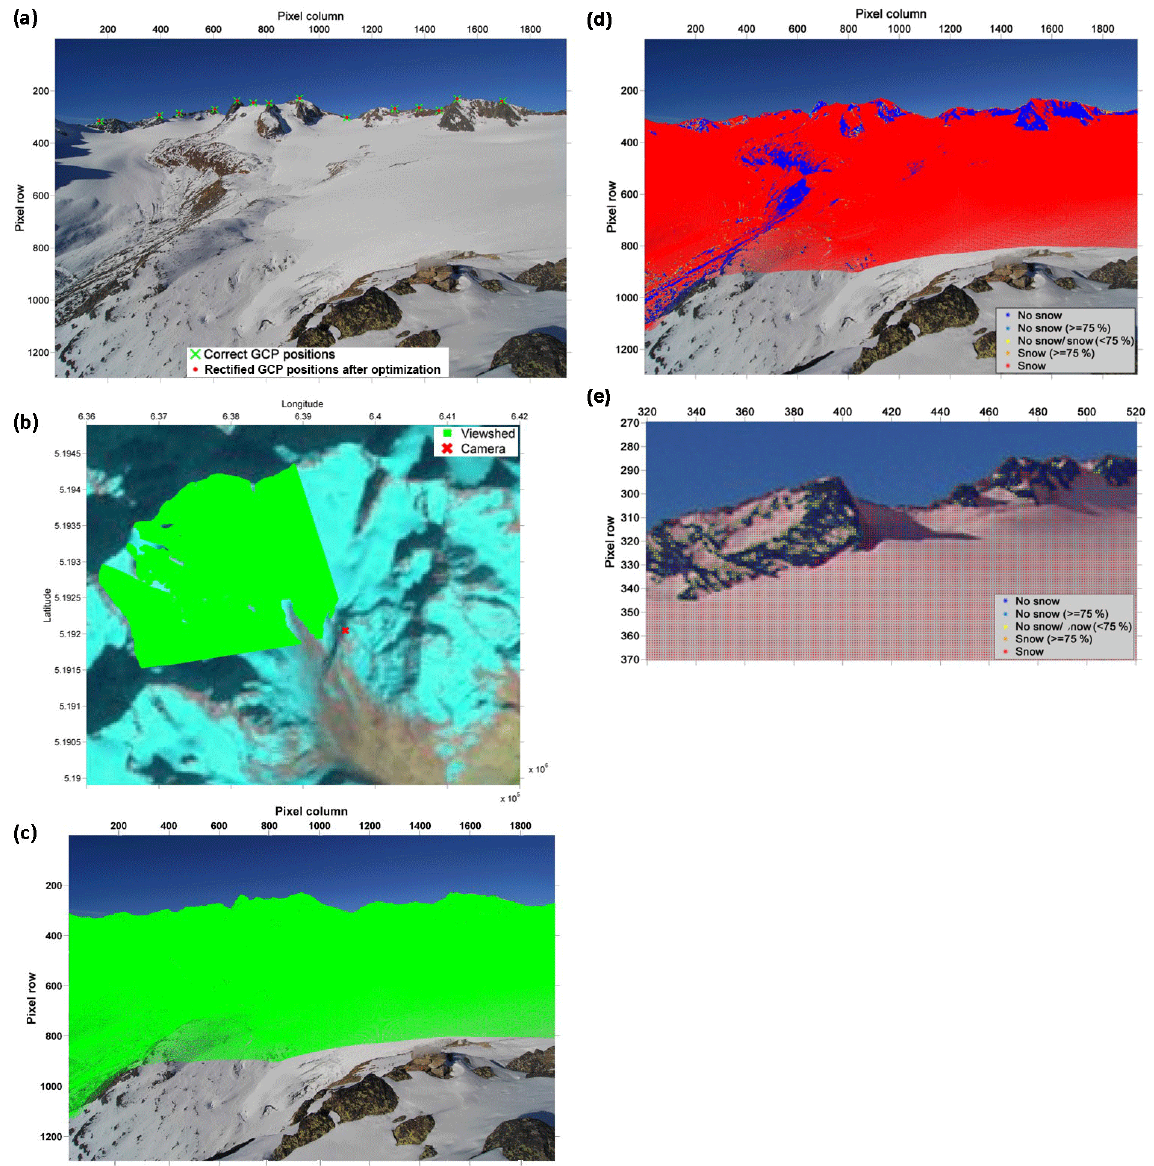
Figure 4. Internal processing steps within a single PRACTISE evaluation are shown for a photograph of VF on 17 November 2011. The figures chronologically show the routines for the photograph processing in PRACTISE which are (a) the optimization of the camera location and orientation using ground control points, (b) the viewshed analysis performed using the resulting camera location and orientation, (c) the projection and (d) the classification of visible DEM pixels. More details of the PCA-based classification results in (d) can be seen in an enlarged view in (e)